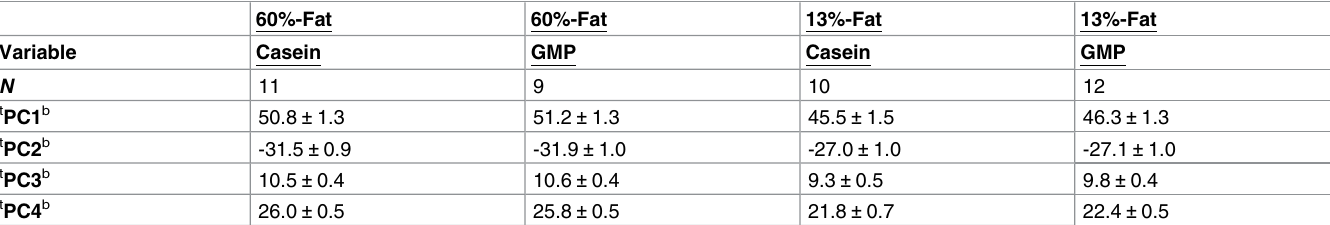
Table 8. Principal component phenotypes of mice fed 60%-fat casein, 60%-fat GMP, 13%-fat casein, and13%-fat GMP